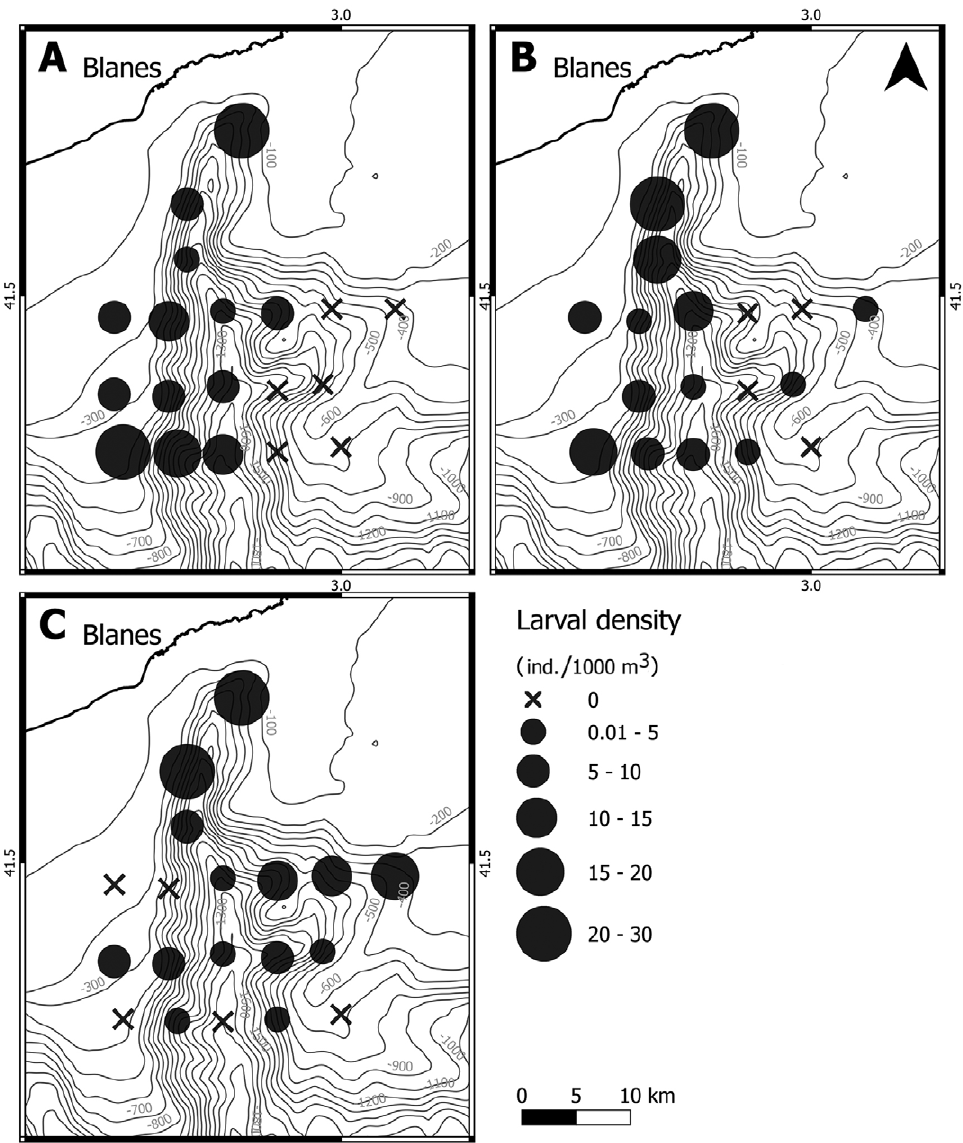
Fig. 5. – Larval density of most frequent species (individuals/1000 m 3 ) for B300. A, Aristeus antennatus. ; B, Sergestidae; C, Alpheus